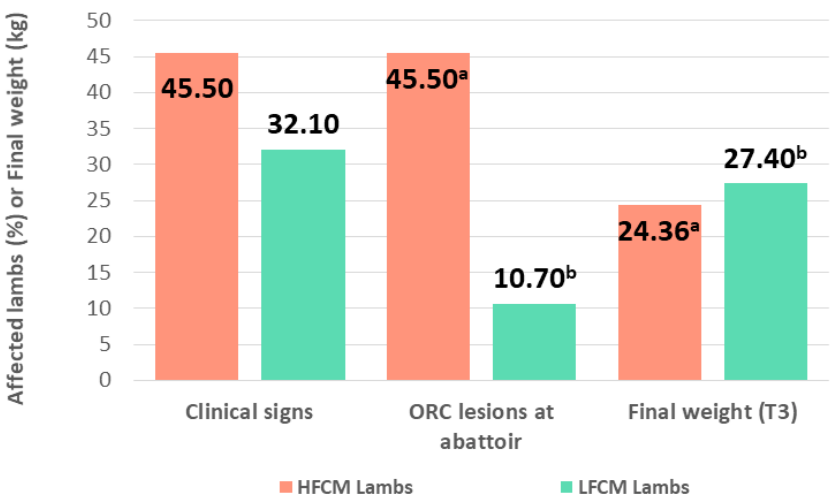
Figure 3. Percentage of lambs with clinical signs of illness throughout the fattening period, percentage of lambs with gross pneumonic lesions compatible with ovine respiratory complex (ORC) identified at the abattoir and average final weight of lambs with concentration of fecal cortisol metabolites at weaning in the highest quartile (HFCM: high fecal cortisol metabolite lambs) and in the lowest quartile (LFCM: low fecal cortisol metabolite lambs). Different letters (x, y) indicate statistically significant differences between the groups ( p < 0.05).